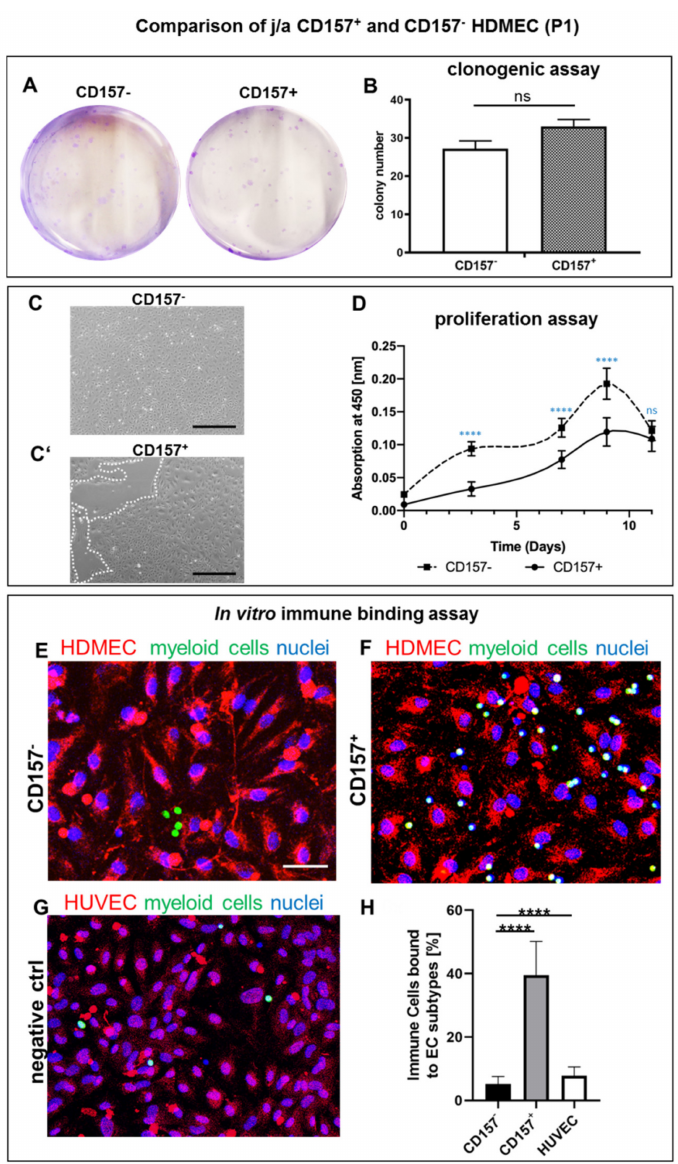
Figure 4. Comparison of clonogenic, proliferation, and immune binding potential of j/a CD157 + and CD157 − HDMEC in vitro ( A , B ) CD157 + and CD157 − HDMEC gave rise to similar colony numbers after sorting ( p = 0.0589, ns; n = 5) ( C , C (cid:48) ). Whereas CD157 − HDMEC rapidly reached a confluent monolayer (C), CD157 + HDMECs demonstrated only a partial confluency ( C (cid:48) ). White dashed lines delineate the areas not covered by cells (n = 5, scale bar: 50 µ m). ( D ) Colorimetric proliferation assays with CD157 + and CD157 − using 1 × 10 4 seeded cells in 24-well plates were conducted at d = 0, 3, 7, 9, 11 (n = 5, p ≤ 0.0001). ( E – H ) In vitro immune binding assay reveals strong adhesion of CD11b expressing myeloid cells to CD157 + (39.5 ± 10.7%), but only weak adhesion to CD157 − (5.2 ± 2.4%, **** p < 0.0001 extremely significant) or HUVEC (7.8 ± 2.8%, **** p < 0.0001 extremely significant). Statistical tests were performed using two-way